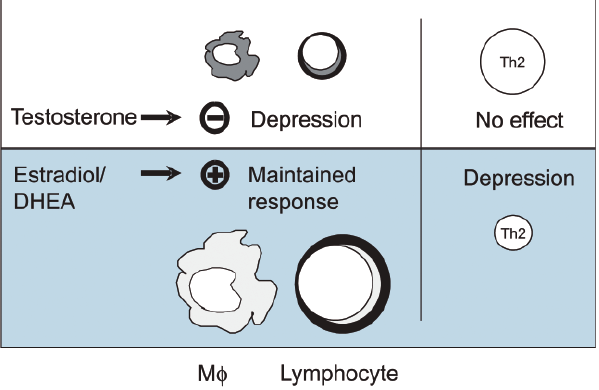
Figure 2 - Schematic illustration of the effect of male and female sex hormones on cell-mediated immune responses, ie, macrophage function and Th1 and Th2 lymphocyte responses following trauma and severe blood